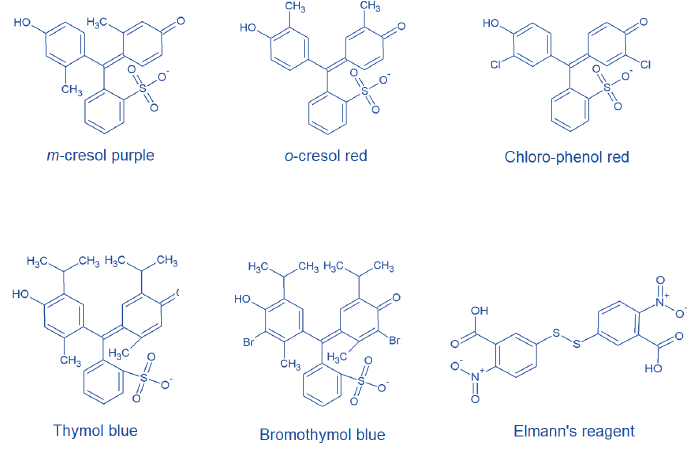
Figure 14. Structure of the dyes used for preparing EVOH-based optode for evaluating high-protein food spoilage (Adapted with permission from [38], Copyright 2020, ACS). Sensors change color depending on the ambient pH in which they are introduced. RGB data were collected and analyzed thanks to principal component analysis.